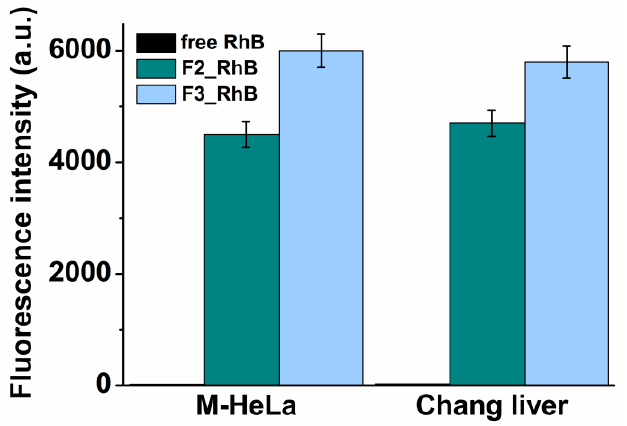
Figure 7. Cellular uptake study of chitosomes: (1) Free RhB; (2) F2_RhB; (3) F3_RhB after 24 h incubation. The location of chitosomes within the same cell lines was studied using fluorescent microscopy. The nuclei were stained with the DNA-intercalating dye DAPI. The